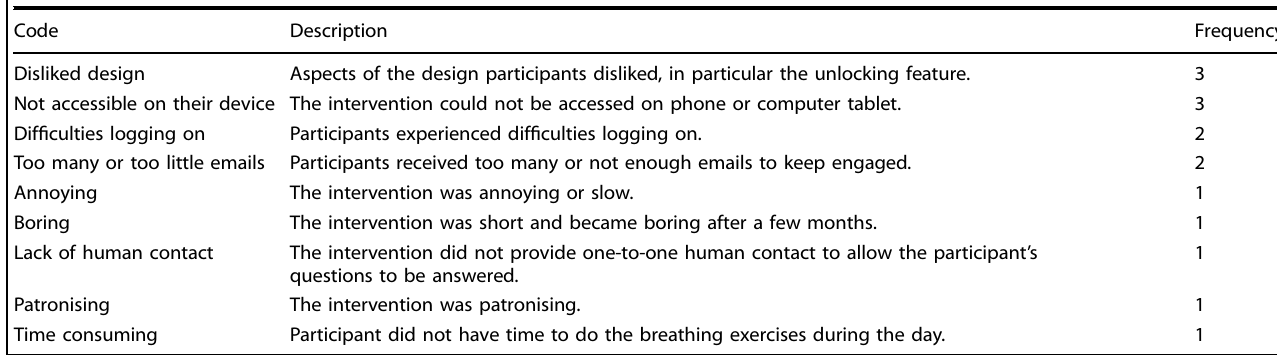
Table 4. Content analysis of free-text comments regarding disadvantages of using My Breathing Matters ( n = 13). Code Description Frequency Disliked design